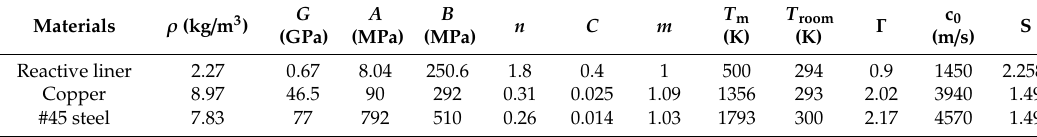
Table 3. Parameters of the reactive liner [24,34], copper [35], and #45 steel [24] materials.